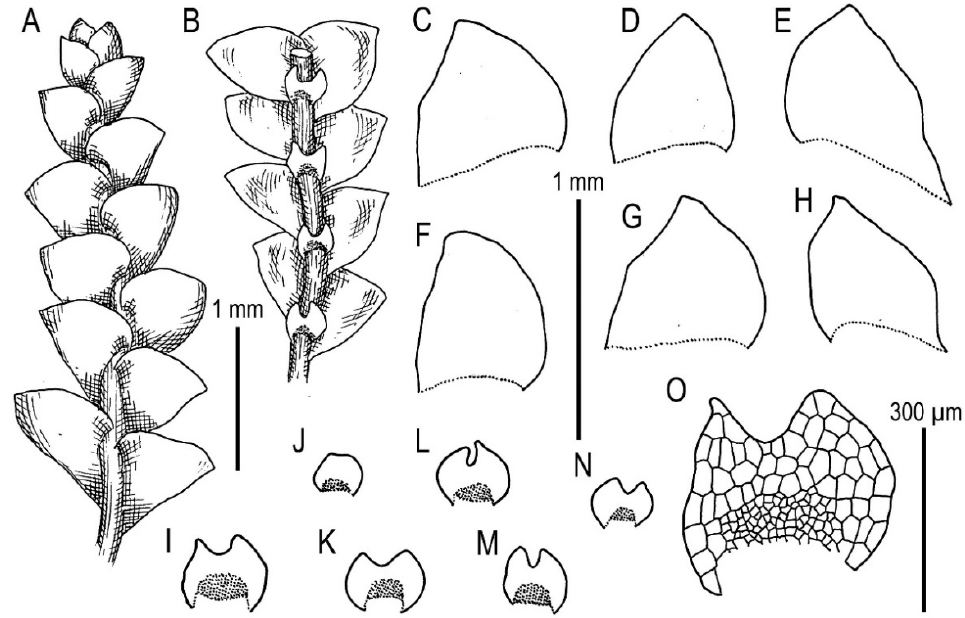
Figure 8. Calypogeia cuspidata (Steph.) Steph.: ( A ) Plant habit, fragment, dorsal view; ( B ) Plant habit, fragment, ventral view; ( C – H ) Leaves; ( I – O ) Underleaves. All from C-44-1-17 (VBGI).